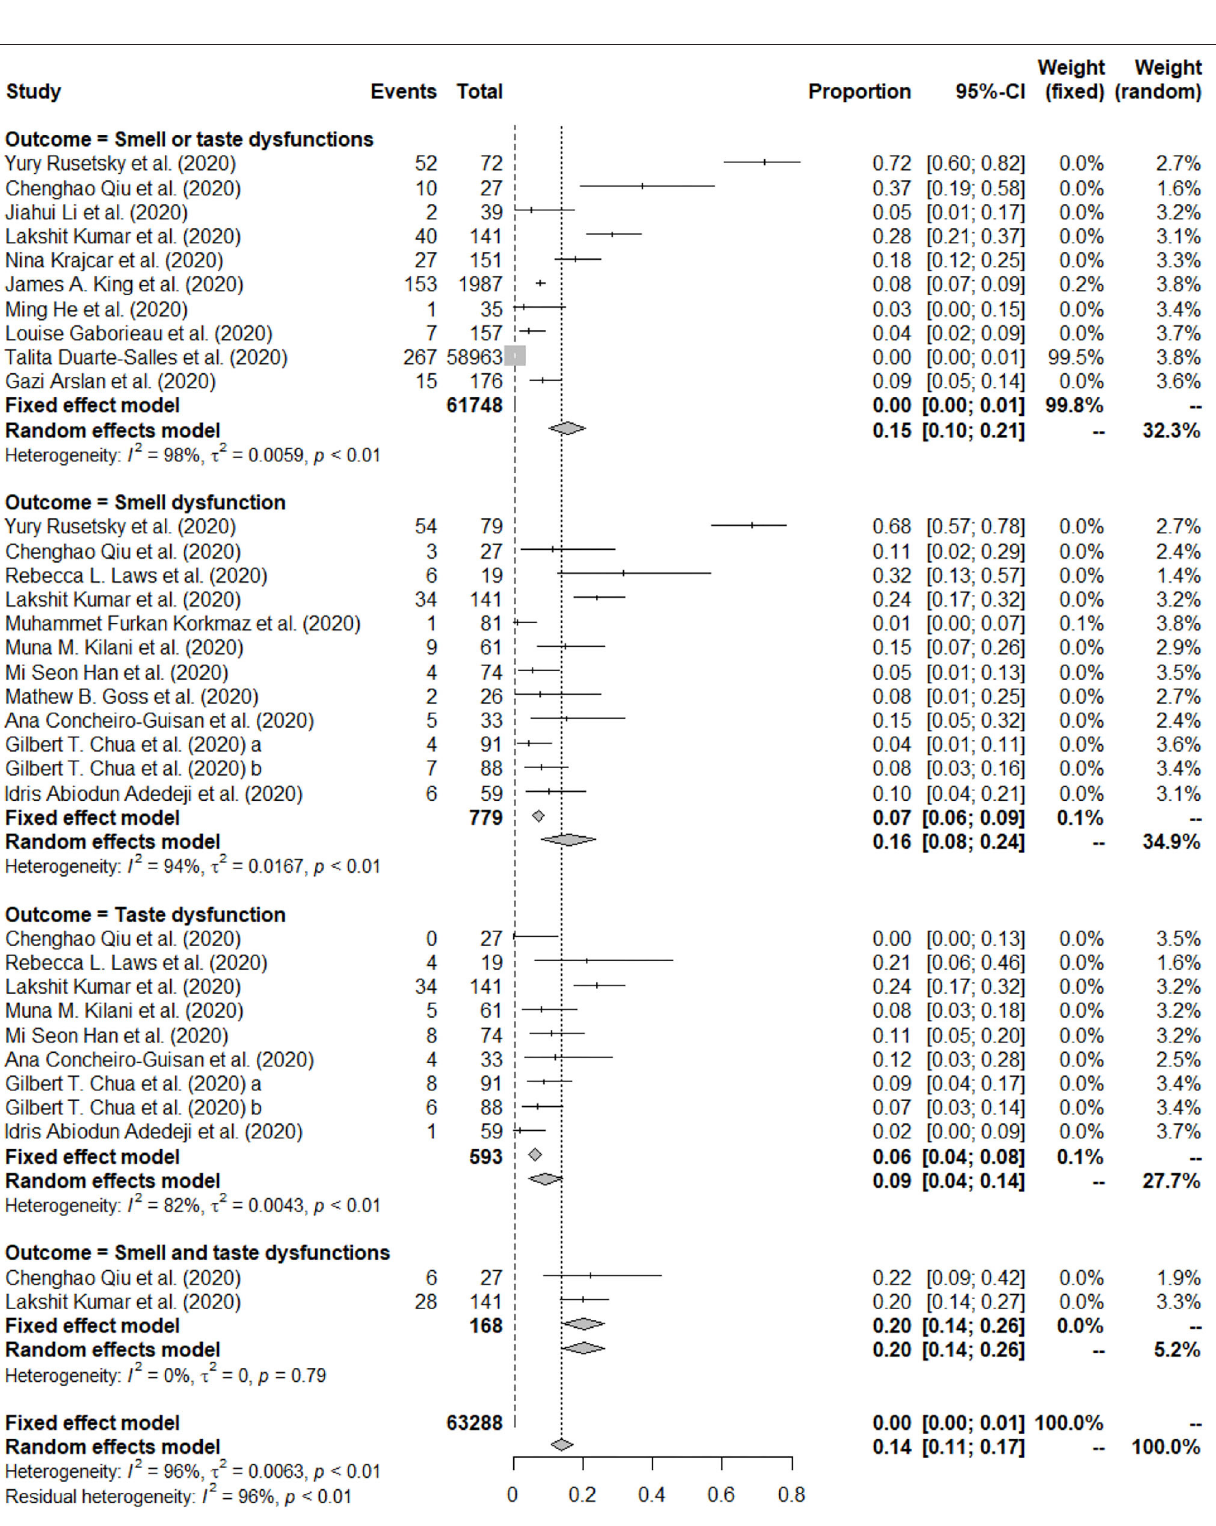
Frontiers in Pediatrics |